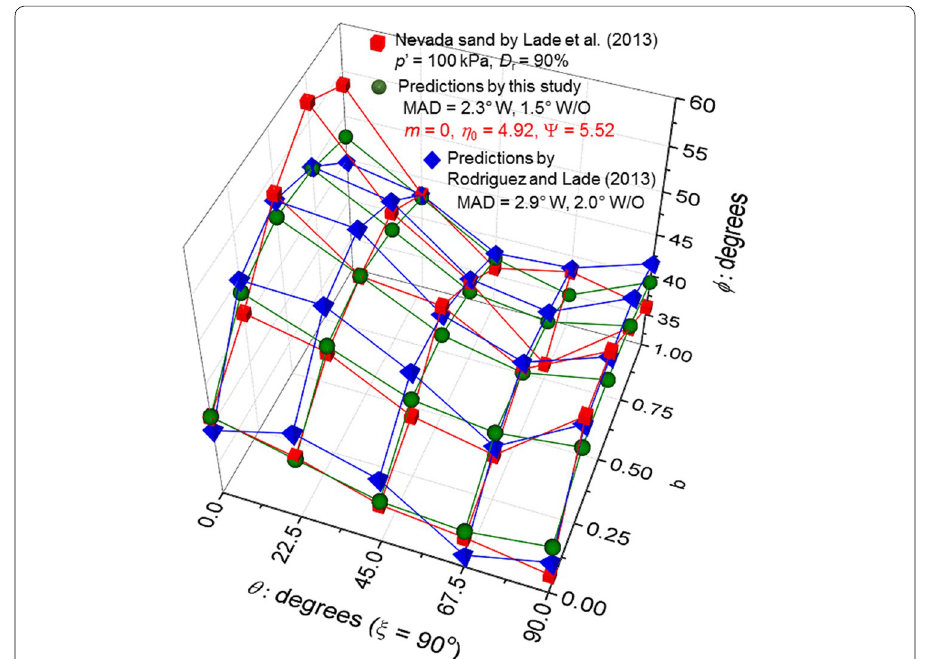
Fig. 12 Comparison between torsion shear test results of Nevada sand and predictions by this study and by Rodriguez and Lade